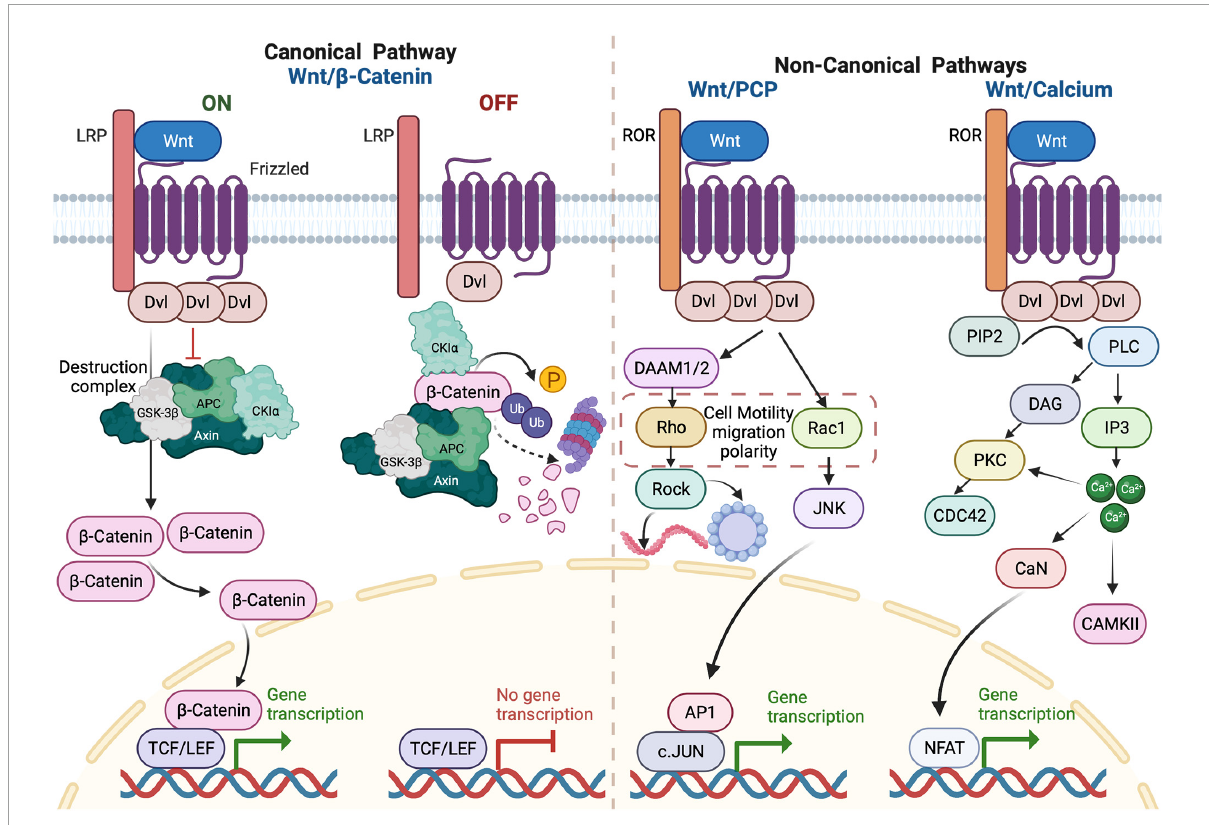
FIGURE2 Overview of WNT signaling pathways. In the ON state of the canonical pathway, the binding of WNT to frizzled (FZD) receptor and LRP on the plasma membrane results in activation of DVL protein in the form of polymerization. When polymerized, DVL adaptor proteins inhibit the destruction complex (Axin, GSK-3 β , APC, and CKI α ) function, leading to unphosphorylated β -catenin accumulation and nuclear translocation. In the nucleus, β -catenin acts as a transcriptional co-activator to TCF/LEF factors that, in turn, activate the transcription of WNT target genes. In the OFF state, there is no WNT ligand binding and no DVL polymerization and β -catenin undergoes phosphorylation by components of the destruction complex. This phosphorylation triggers ubiquitylation of β -catenin and its consequent proteasomal degradation. In WNT/PCP, the binding of WNT ligand to FZD receptor and the receptor tyrosine kinase-like orphan receptor (ROR) on the plasma membrane recruits and activates DVL protein. This binding initiates a cascade of signals via Rho or Rac GTPases to promote polarized cellular behaviors or promote cell survival by activating the transcription of AP1 target genes. The binding of the WNT ligand to the FZD receptor and ROR also activates the WNT/Ca 2 + signaling by G-protein-dependent release of Ca 2 + . The increase of intracellular calcium activates PKC and CAMKII. Increased Ca 2 + can also activate calcineurin, leading to the accumulation of nuclear factor of activated T cells (NFAT) in the nucleus and promoting transcription of target